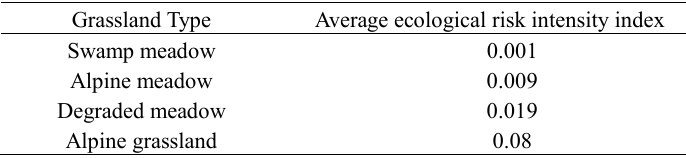
Table 4. Statistical table of average ecological risk intensity index of alpine grassland Formula (1) is used to calculate the ecological risk intensity degradation. A large number of grasslands are transformed into index of Alpine Grassland in the source area of the Yellow bare land. The fragmentation is increasing, the connectivity River (Table 4). The average ecological risk intensity index is between patches is low, and the stability of regional natural swamp meadow < alpine meadow < degraded meadow < alpine ecosystem is low, which leads to the increase of ecological risk grassland. The Alpine Grassland in the source area of the Yellow River is in the dangerous period of grassland